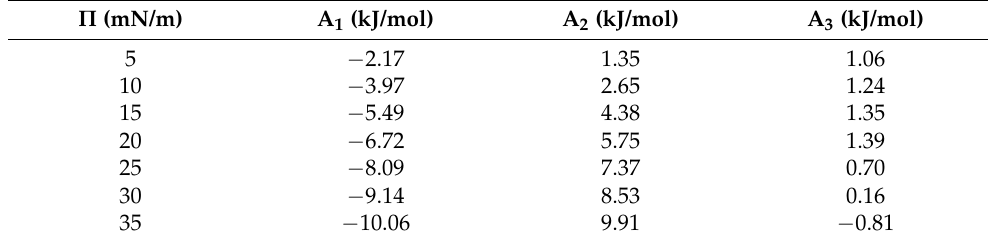
Table 1. Coefficient obtained for the best fit of the experimental data of the excess free energy for the mixture to Equation (10) at 24 ◦ C.